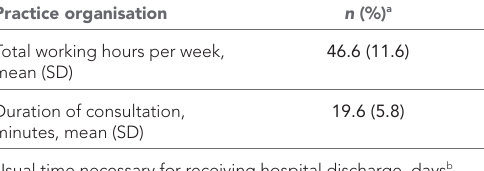
Table 1 Characteristics of participating GPs Sociodemographic characteristics